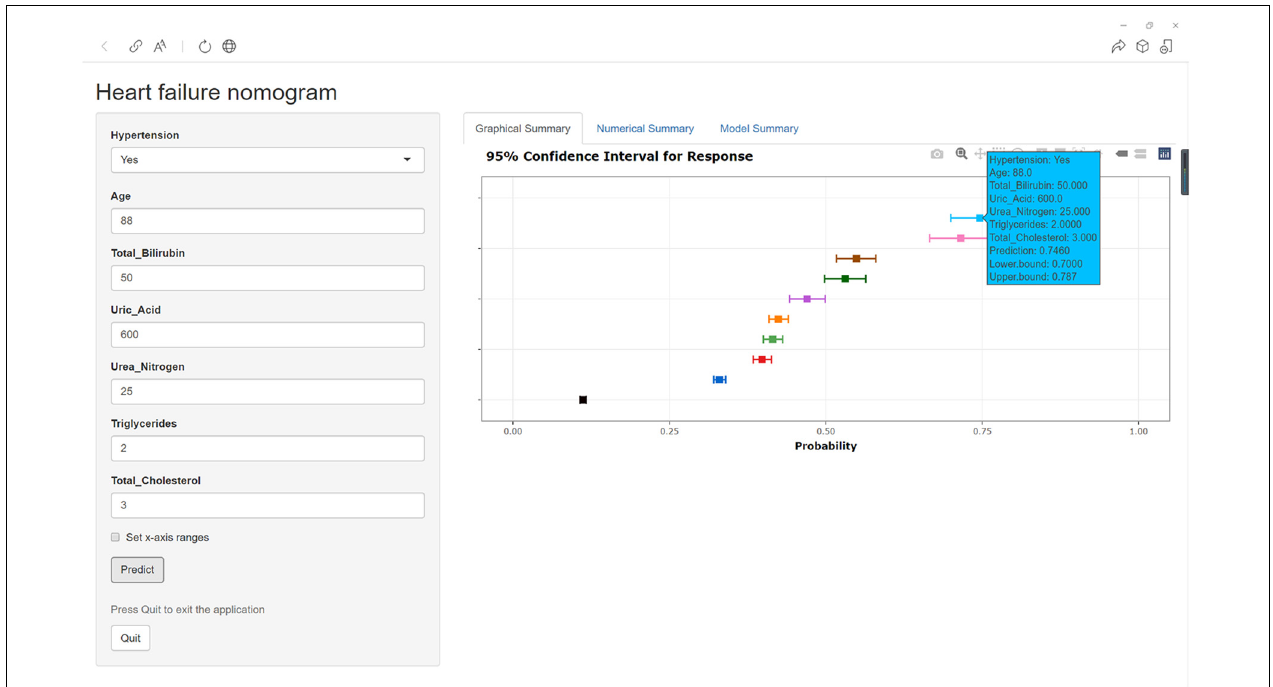
FIGURE 7 | An example of HF prediction using the nomogram in patients with CHD via a link.